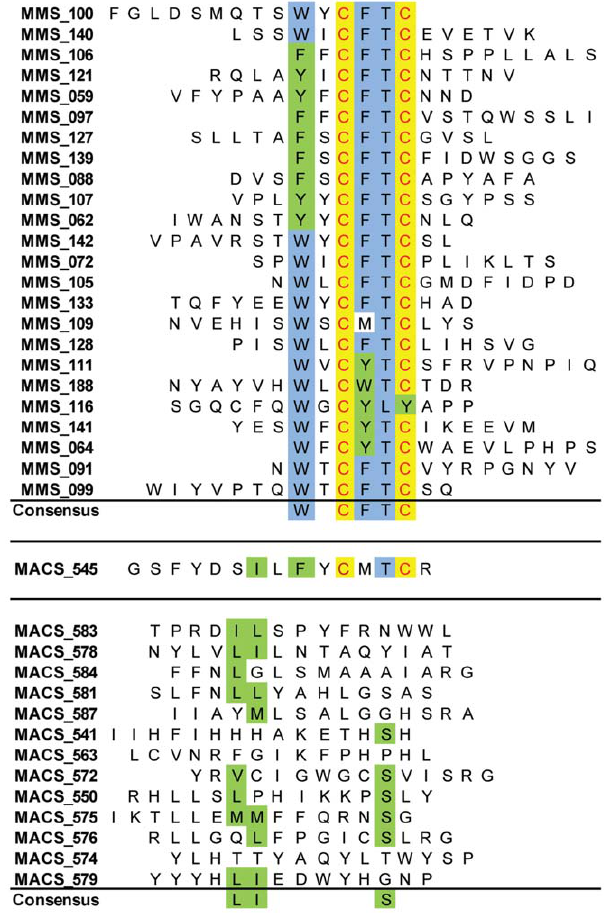
Figure 6. Sequence Alignment of MMS and MACS/FACS Sorts. Peptide sequences of clones selected by MMS system and MACS for binding to protective antigen. Conserved residues are highlighted in blue, similar residues in green, and identical residues in yellow. All of the twenty-four MMS selected sequences and one of the MACS sequences contained a six residue consensus sequence of WXCFTC.